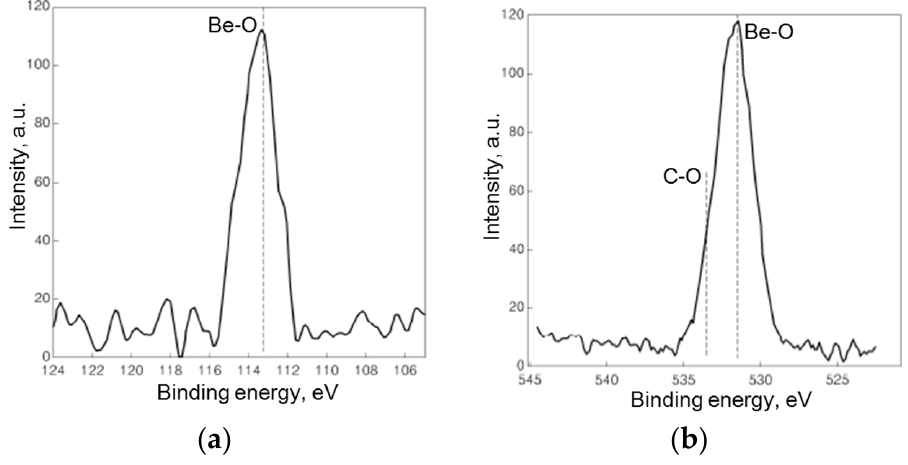
Figure 2. XPS spectra of Pt–BeO: ( a ) Be 2s and ( b ) O 2p.